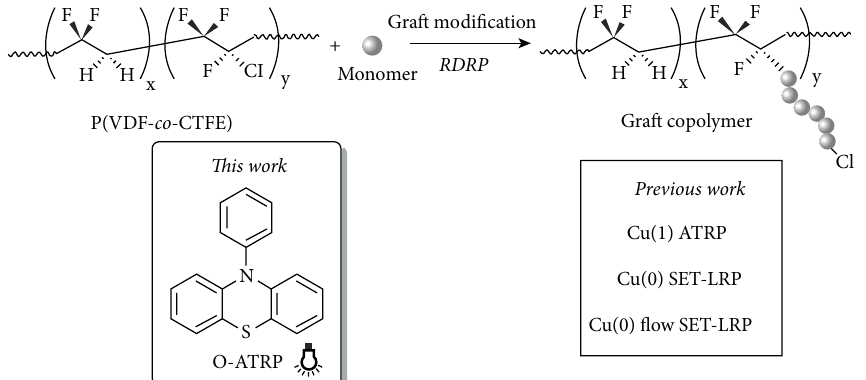
Figure 3: Poly(vinylidene fluoride- co -chlorotrifluoroethylene) modification via organocatalyzed atom transfer radical polymerization. (Adapted with permission from Ref.